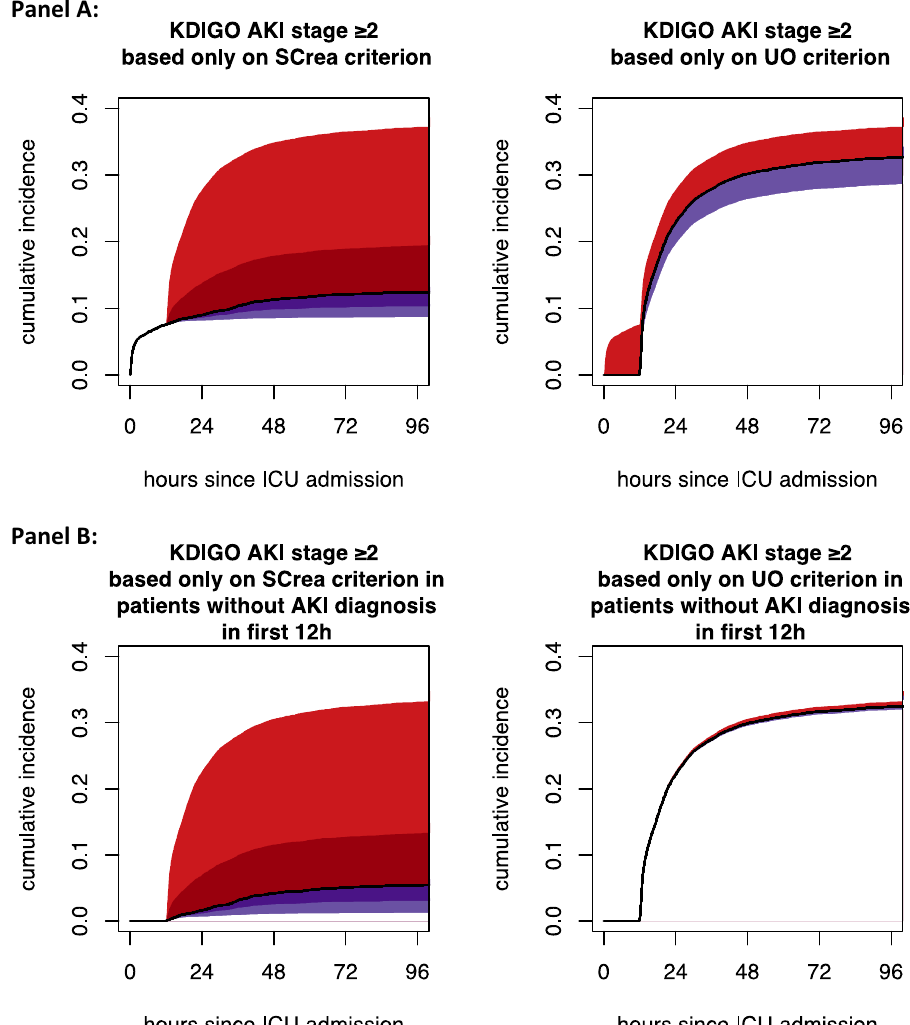
Figure 2. Cumulative incidence of automated AKI diagnosis over time. ( A ) Cumulative incidence of automated AKI diagnosis since ICU admission, based only on KDIGO Screa criterion (left) or only on KDIGO UO criterion (right) (black curves). Shaded areas represent cases that were, by each time point, either missed (red) or diagnosed with delay (purple) by ignoring the other criterion. (Dark shades in the left panel indicate missed or delayed cases compared to the UO-2 criterion, while the combination of light and dark shades in the left panel indicate missed or delayed cases compared to the UO-1 criterion). ( B ) Cumulative incidence of automated AKI diagnosis in patients still hospitalized and without AKI diagnosis by the 12th hour since ICU admission, based only on KDIGO Screa criterion (left) or only on KDIGO UO criterion (right) (black curves). Shaded areas represent cases that were, by each time point, either missed (red) or diagnosed with delay (purple) by ignoring the other